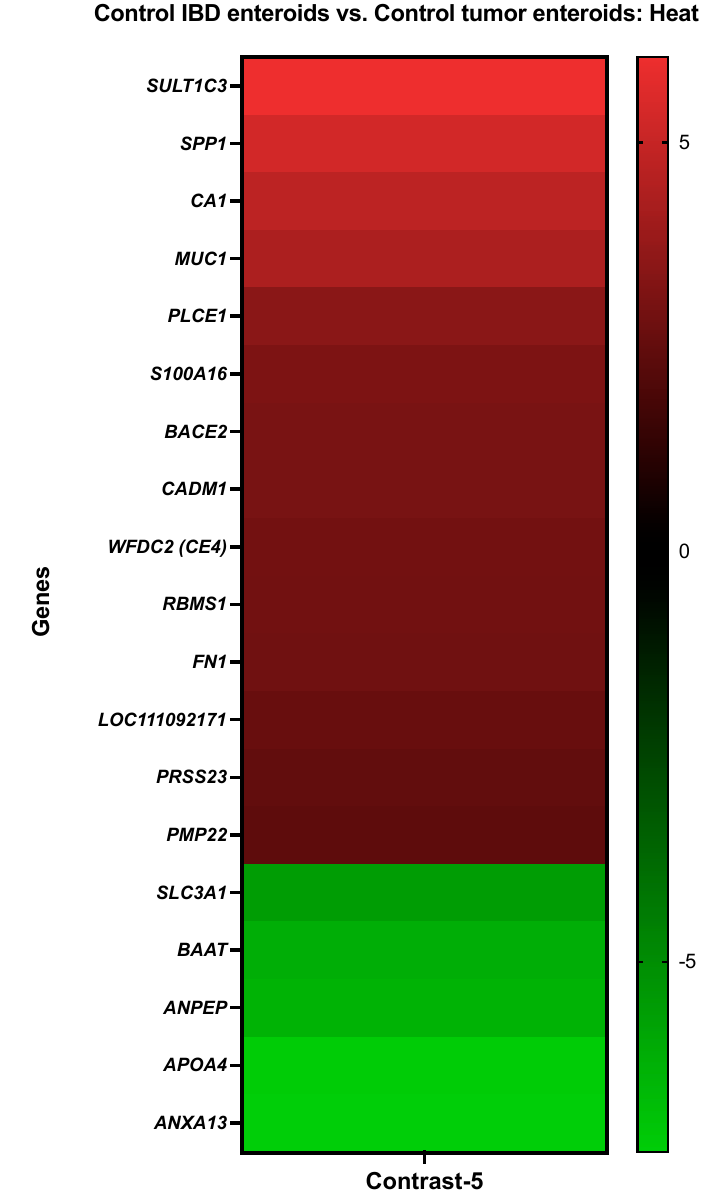
Figure 6. A heat map depicting the color-coded expression levels (log-ratio M values) of the top 14 upregulated and five downregulated DEGs in the control IBD enteroids vs. the control tumor enteroids (Contrast-5). The log-ratio M values represent the log(R/G) (log fold change) [44]. The detailed information on genes is presented in Table 8.